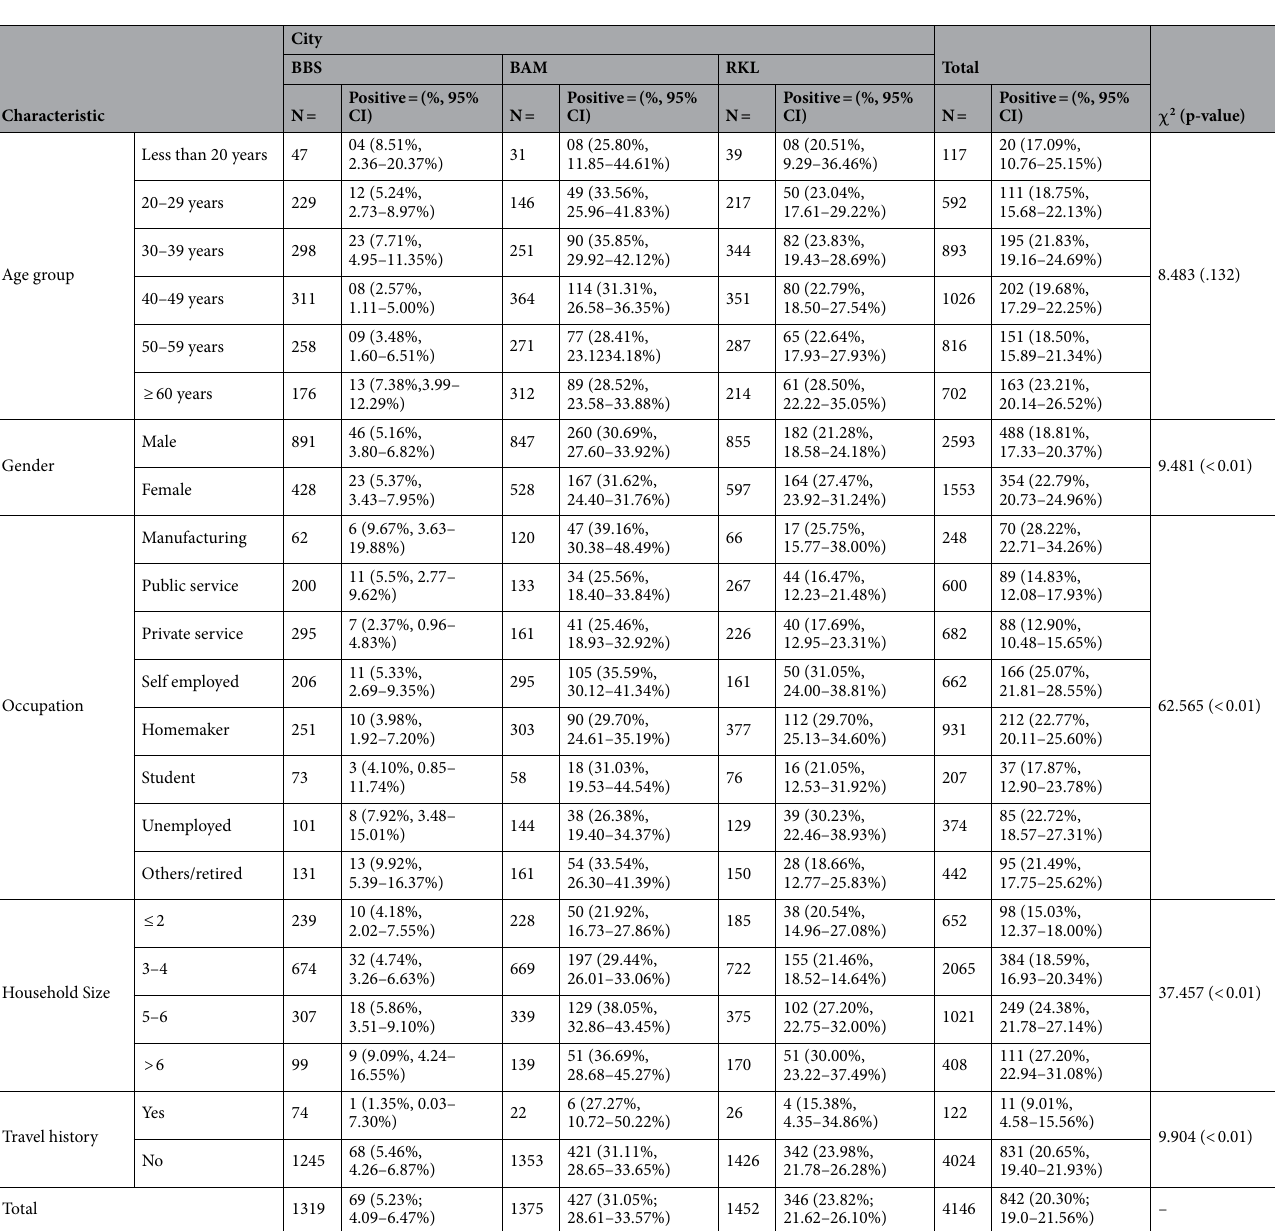
Table 1. Demographic characteristics of the study population and the distribution of